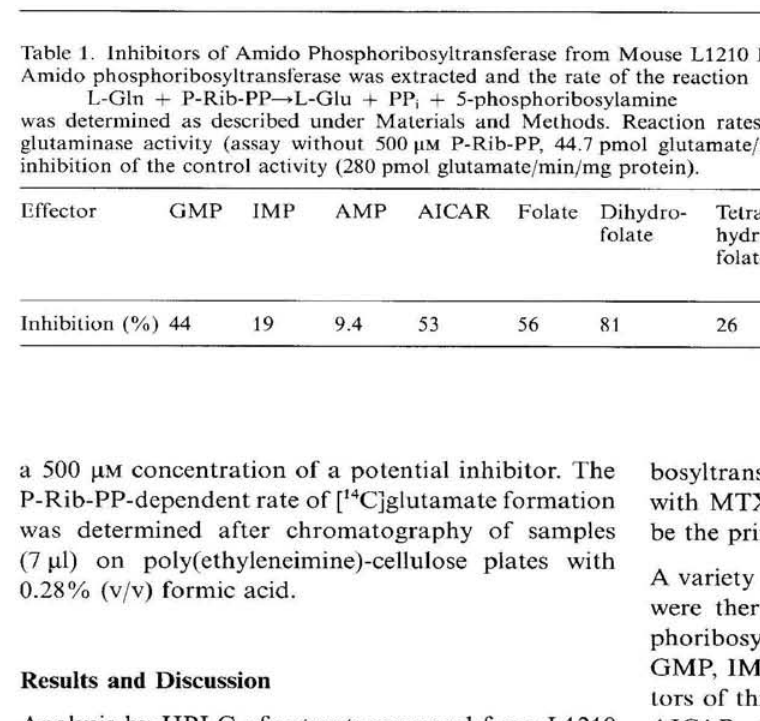
Table 1. Inhibitors of Amido Phosphoribosyltransferase from Mouse L1210 Leukaemia Cells Amido phosphoribosyltransferase was extracted and the rate of the